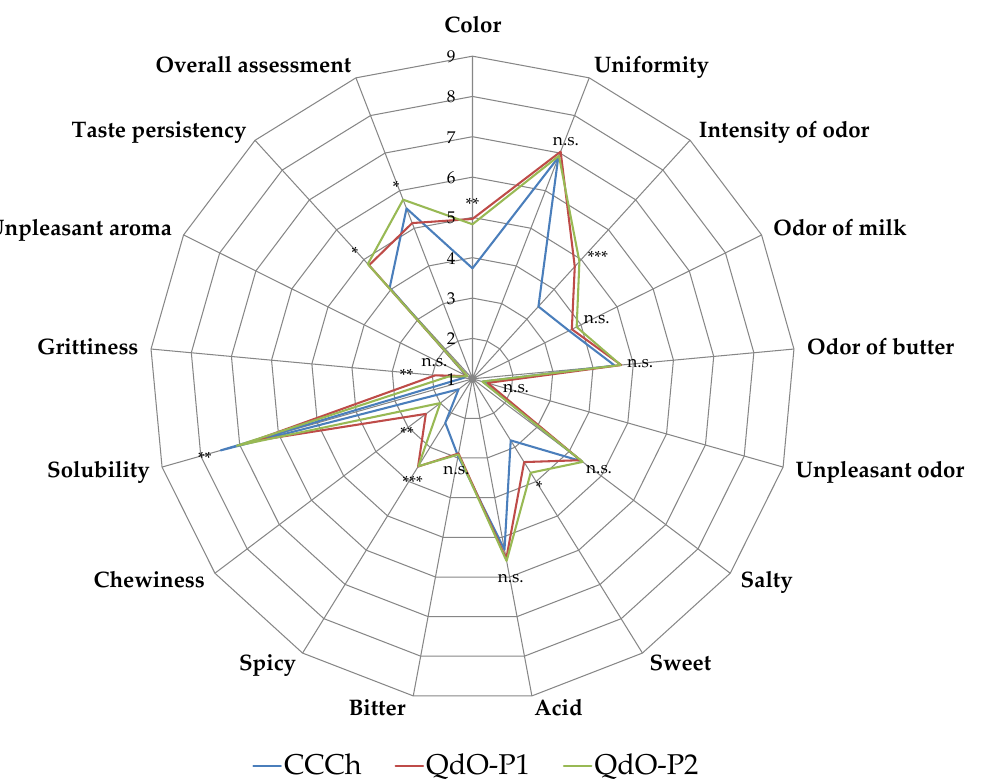
Figure 3. Spider diagrams of descriptive sensory analysis of cheeses. Abbreviations: CCCh, commercial crescenza cheese; QdO-P1, Quadrello di ovino cheese produced with starter culture SF1 (starter formulation CR/A); QdO-P2, Quadrello di ovino cheese produced with starter culture SF2 (starter formulation LYOBAC-D CRM). p value: * p < 0.05; ** p < 0.01; *** p < 0.001; n.s., not significant.